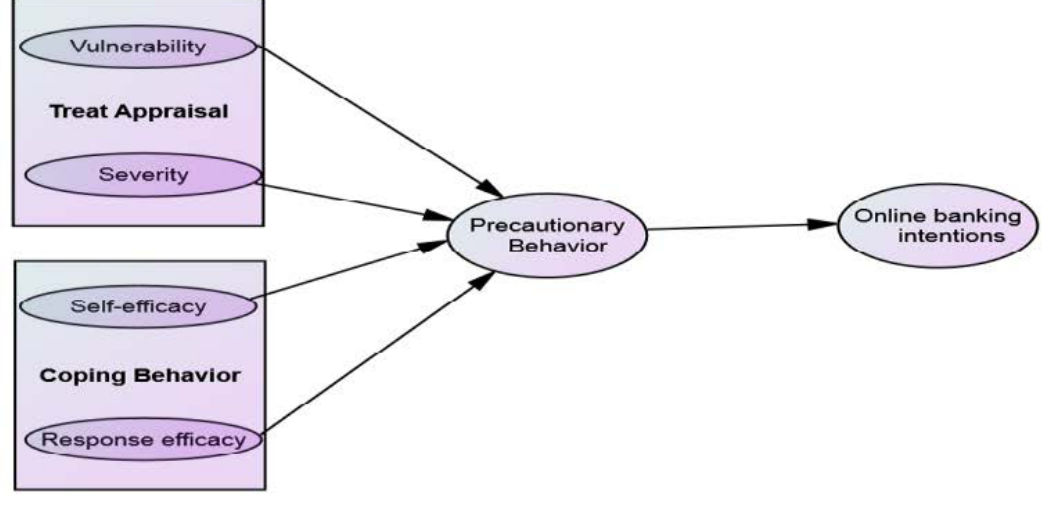
Fig. 1: Conceptual framework of the study